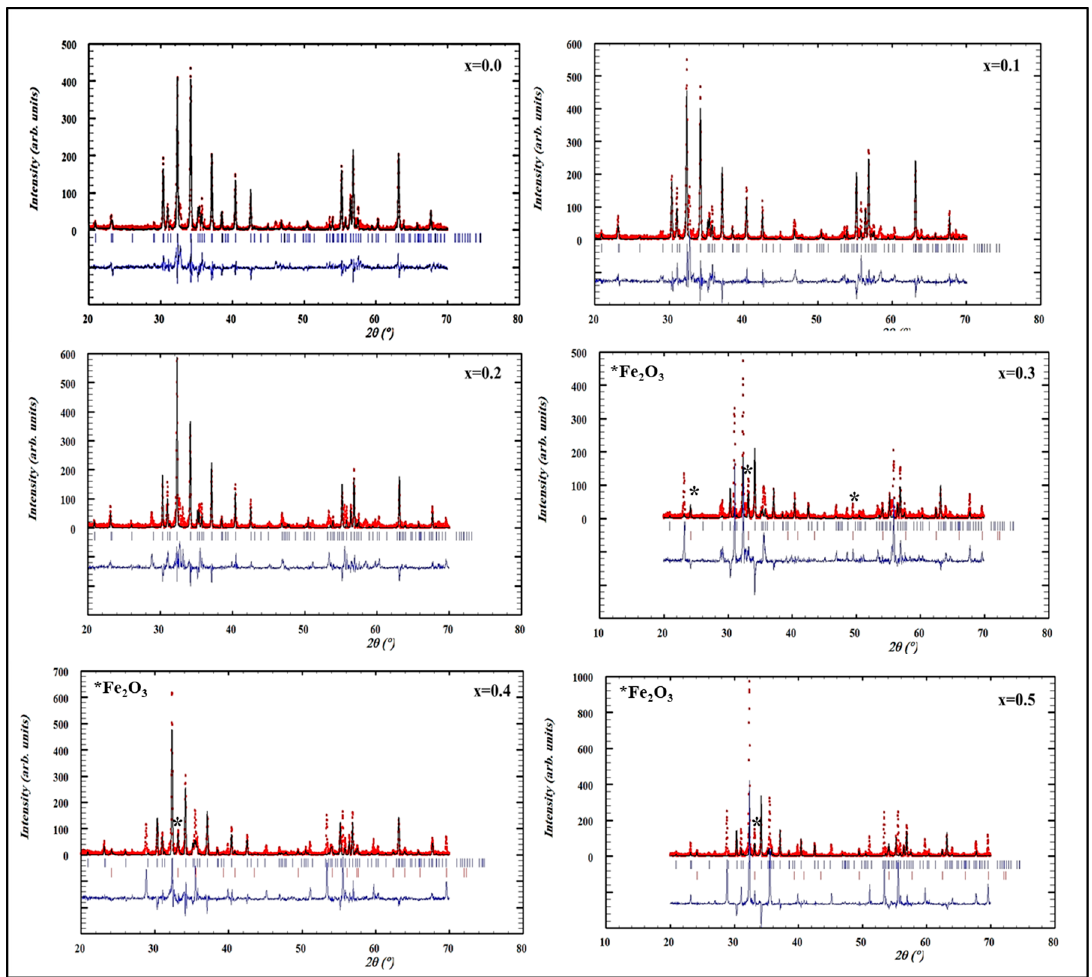
Figure 1. XRD patterns with Rietveld refinement for the various Sr 1 − x Mn x Fe 12 − x Y x O 19 (0.0 ≤ x ≤ 0.5) nanohexaferrites.